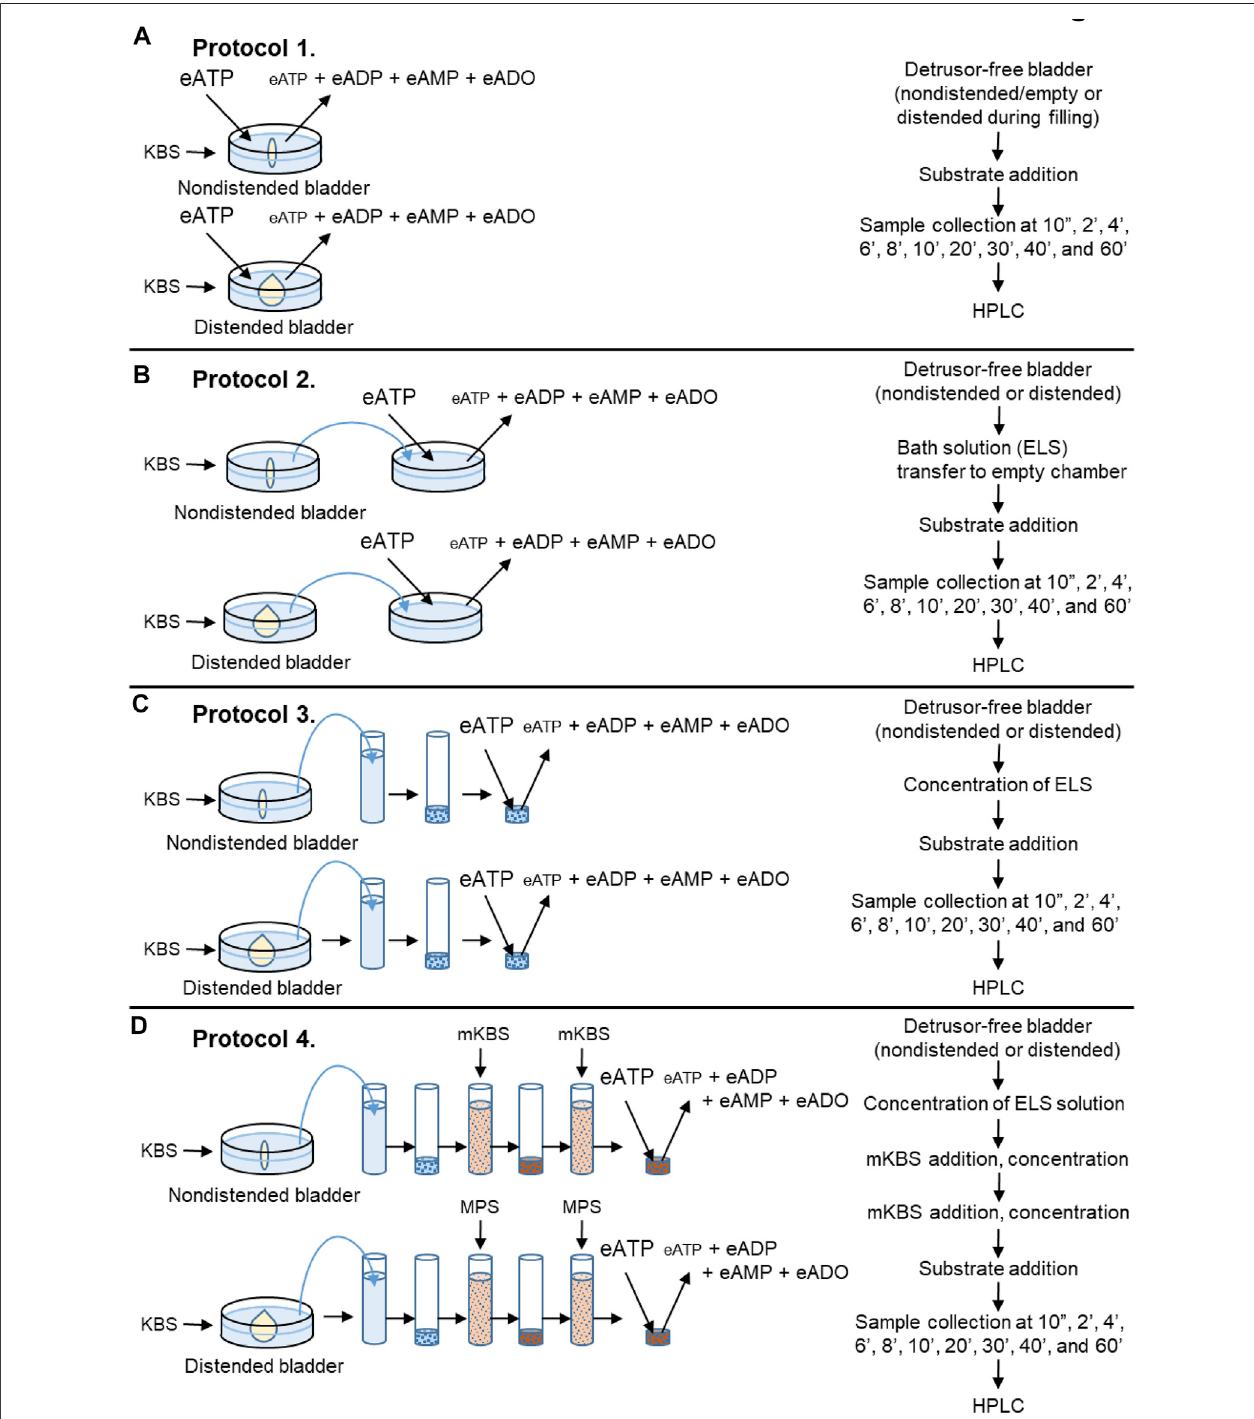
FIGURE 2 | Schematics of experimental procedures for evaluation of eATP degradation in extraluminal solutions from nondistended and distended detrusor-free bladder preparations. (A) Substrate (e.g., eATP or eADP) was added to KBS bathing the bladder preparation. Decrease of substrate and increase of product was measured using HPLC-FLD. (B) Bladder was incubated in KBS. After incubation time equivalent to the time for bladder fi lling, an aliquot of the bath solution (aka extraluminal solution, ELS) was transferred to an empty chamber. Substrate (e.g., eATP or eADP) was added to the transferred ELS and substrate hydrolysis was assessed by HPLC. (C) Bladder was incubated in KBS as described in panel (B) . Then an aliquot of ELS was placed in a fi ltration unit (MWCO 10 kDa) and centrifuged. The supernatant (aka concentrated ELS, cELS) was transferred to an Eppendorf tube to which the substrate was added and substrate decrease and product increase